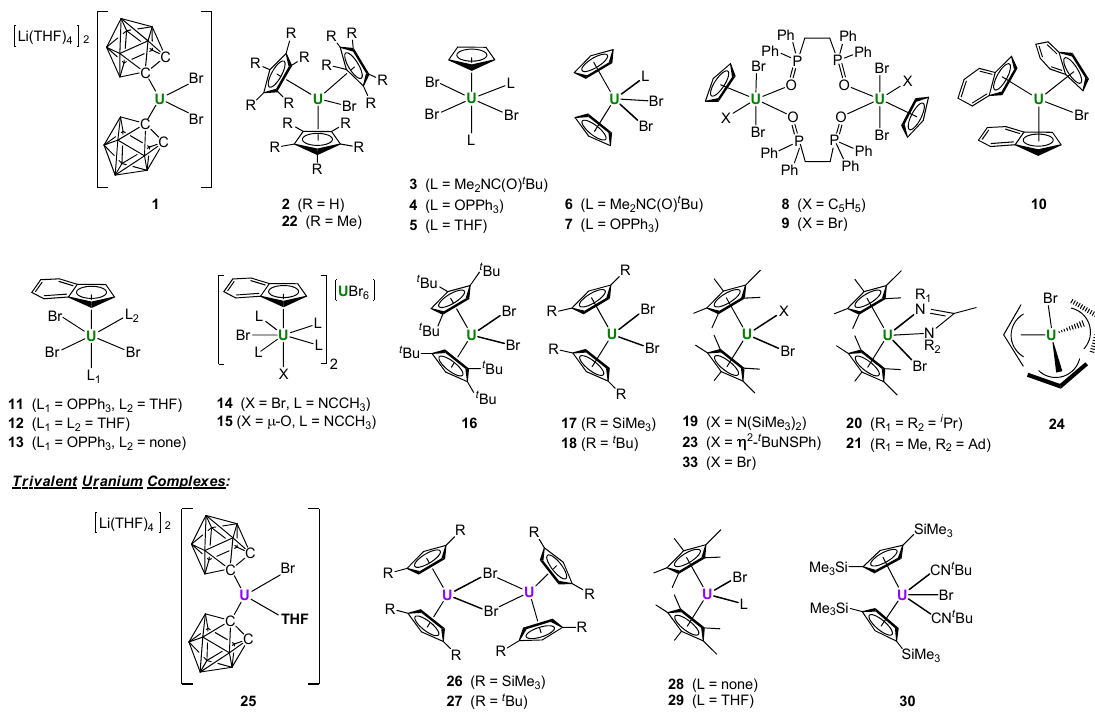
Figure 1. Structures of known organometallic uranium(IV) and uranium(III) bromide compounds.